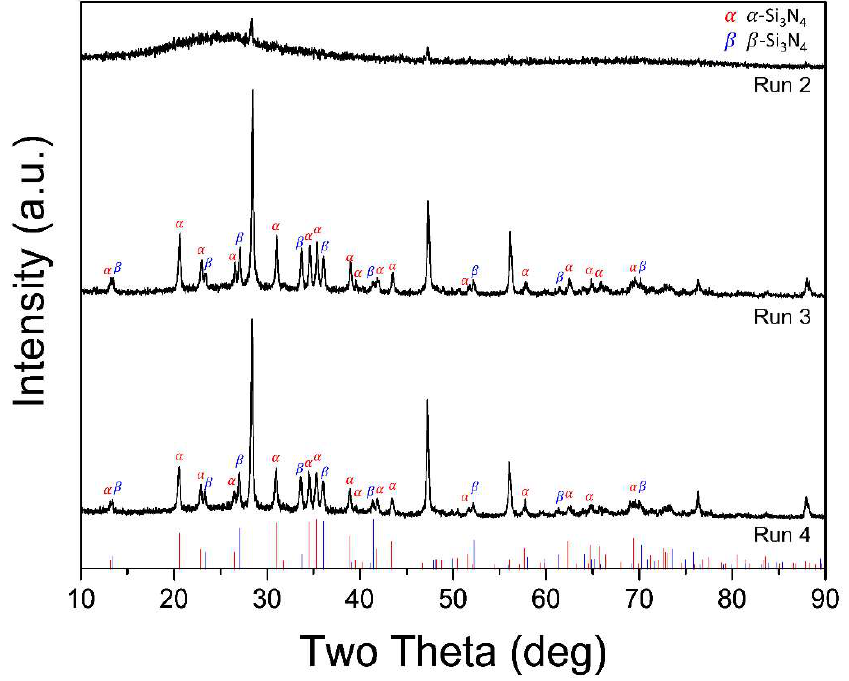
Figure 3. XRD patterns of nanopowders synthesized in Runs 2, 3, and 4 (cone-type reaction